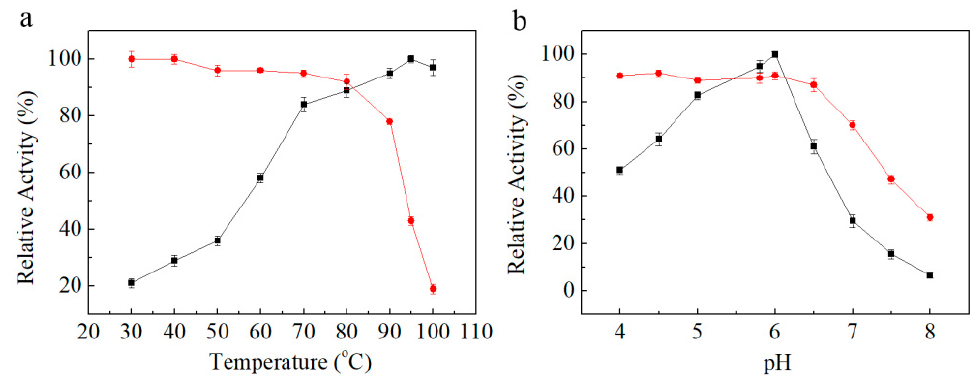
Figure 1. ( a ) Effect of temperature on enzyme activity ( ■ ) and stability ( ● ). ( b ) Effect of pH on enzyme activity ( ■ ) and stability ( ● ). The activities were determined by using gypenoside XLIX as substrate via HPLC analysis.